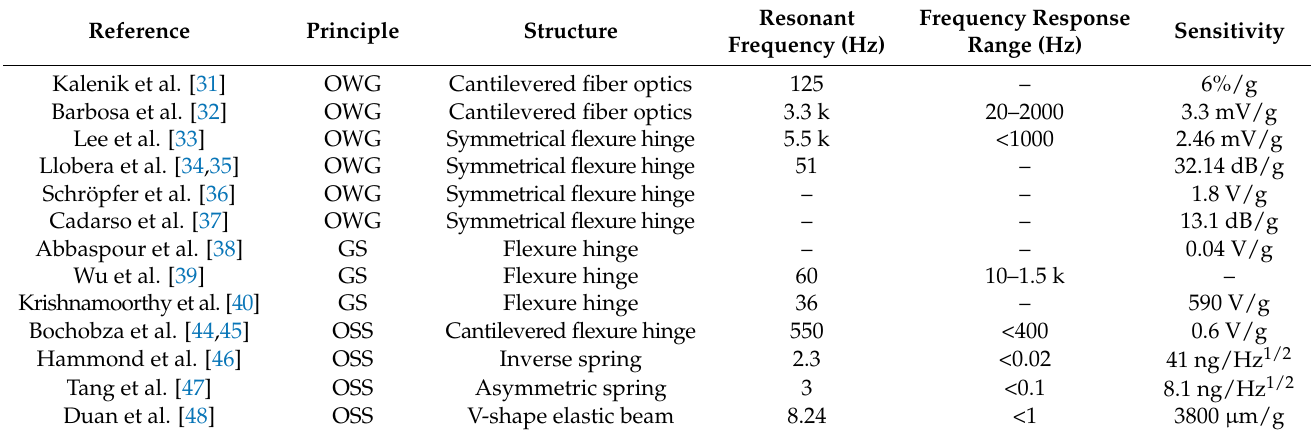
Table 2. Parameters of the accelerometer based on optical intensity